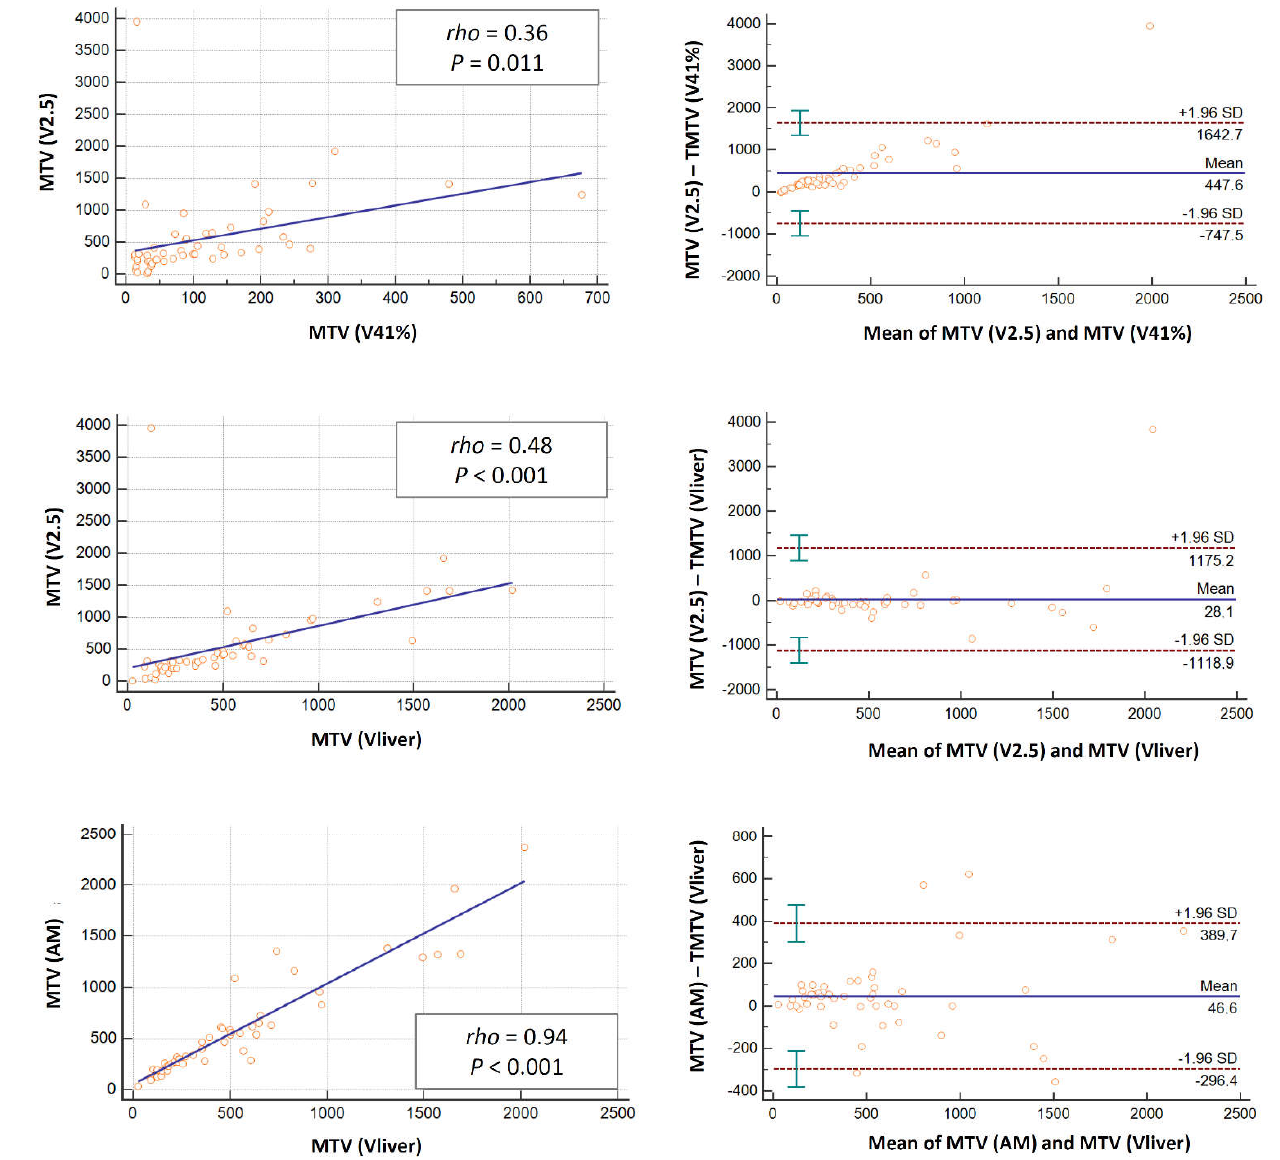
Figure 3. Scatter plots for linear regression with corresponding correlation coefficient (rho) and p -values related to the different segmentation techniques used ( left columns ); Bland-Altman plots ( right columns ) for baseline MTV values showing mean and standard deviations (SD) lines, revealing some outliners in all methods. The closer the data with respect to the mean lines and the lower the variation between SD, the high the comparability of the methods. Herein, the calculated limits of agreement are substantial especially for the V41% method.